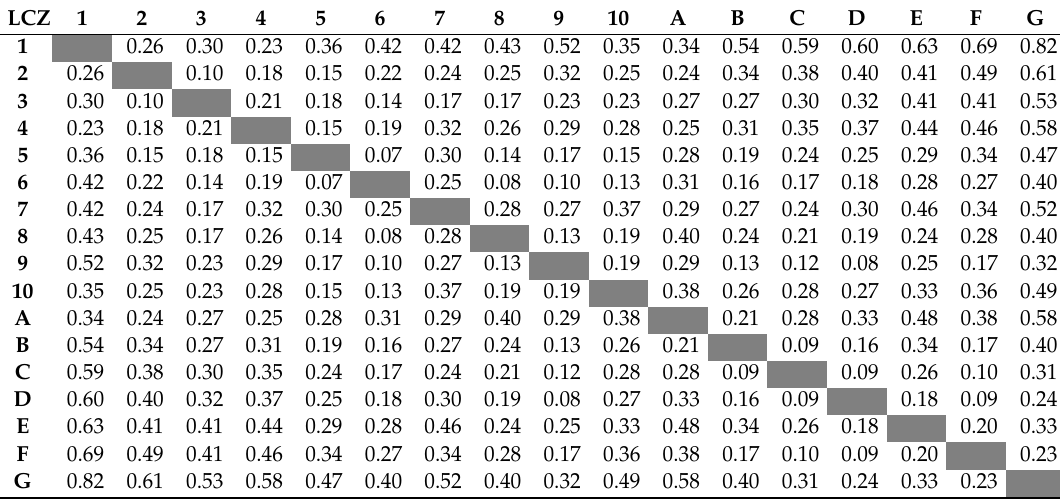
Table 2. LCZ class dissimilarity weights ( D ij ) for the JJ20